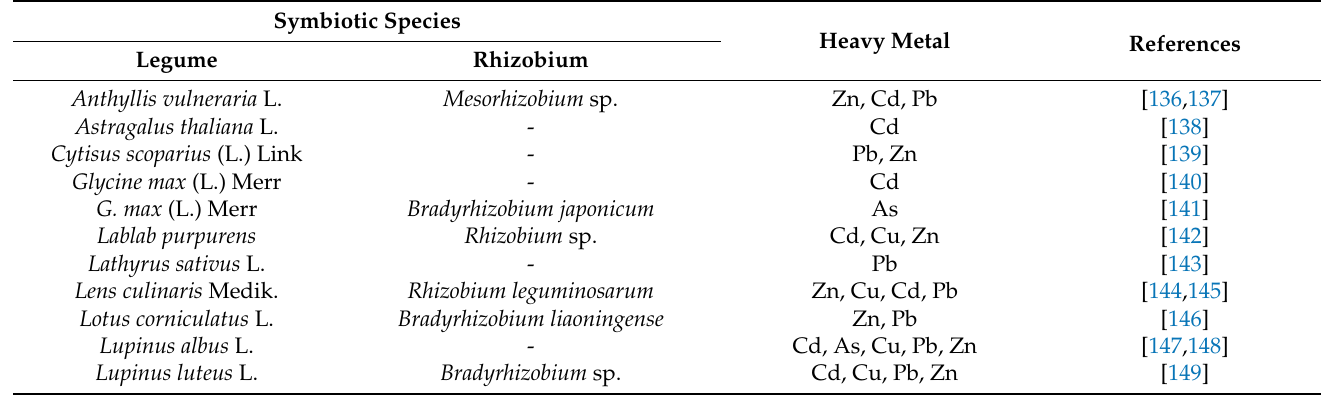
Table 2. Selected wild-type legume plants used for